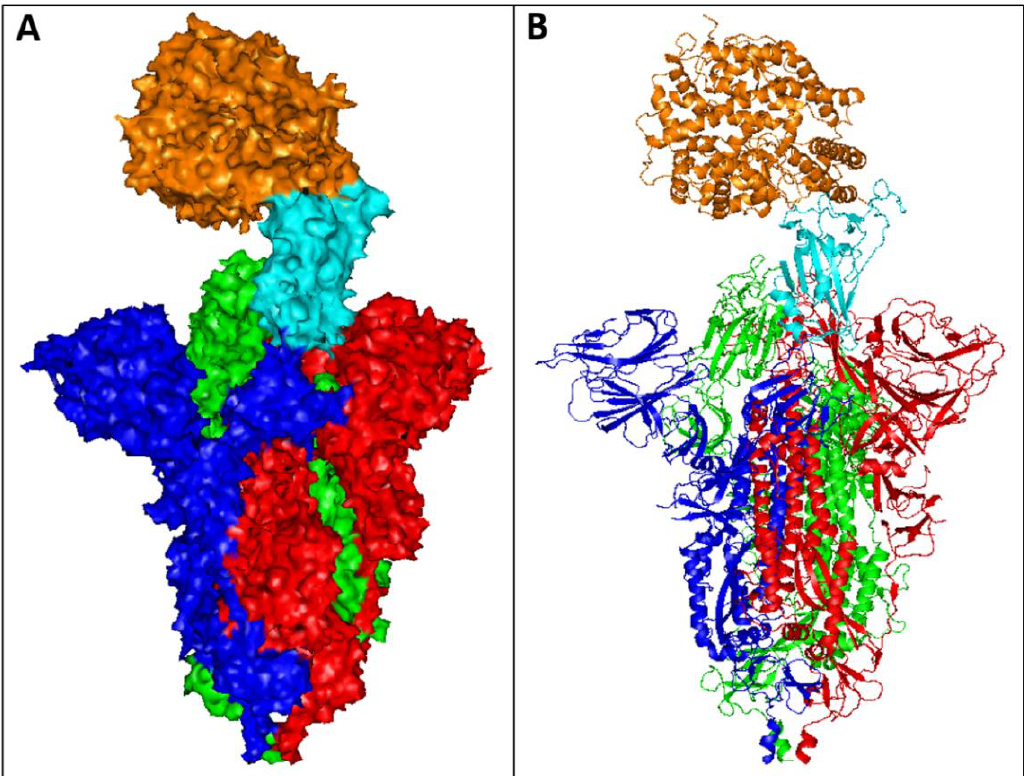
Figure 1. The crystal structure of SARS-CoV-2 S protein complexed with ACE2 receptor retrieved from the Protein Data Bank (PDB), PDB entry 7DF4. The structure was visualised by PyMOL (The PyMOL Molecular Graphics System, Version 1.7.4 Schrödinger, LLC.). The complex is displayed as ( A ) surface and ( B ) loops. The S protein assembles into trimers (coloured red, blue, and green) on the virion surface to form a distinctive “corona”. The RBD domain of the S protein (cyan) binds to the human ACE2 receptor (orange) to promote attachment and fusion.